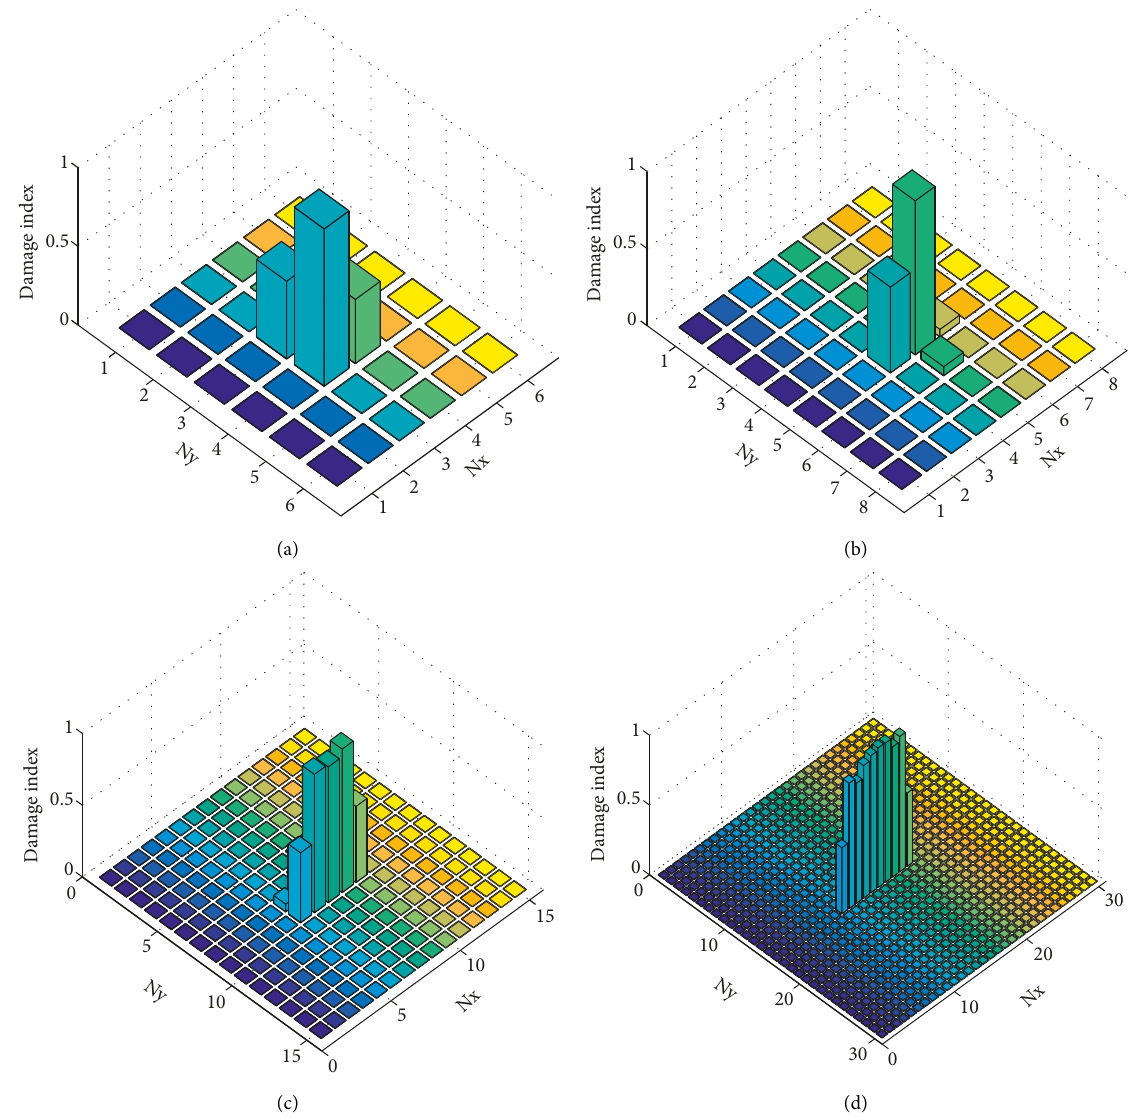
Figure 16: Truncated damage index charts of the first preliminary damaged area using damage threshold 40% Z max 4%, (c) Mesh 2%, and (d) Mesh